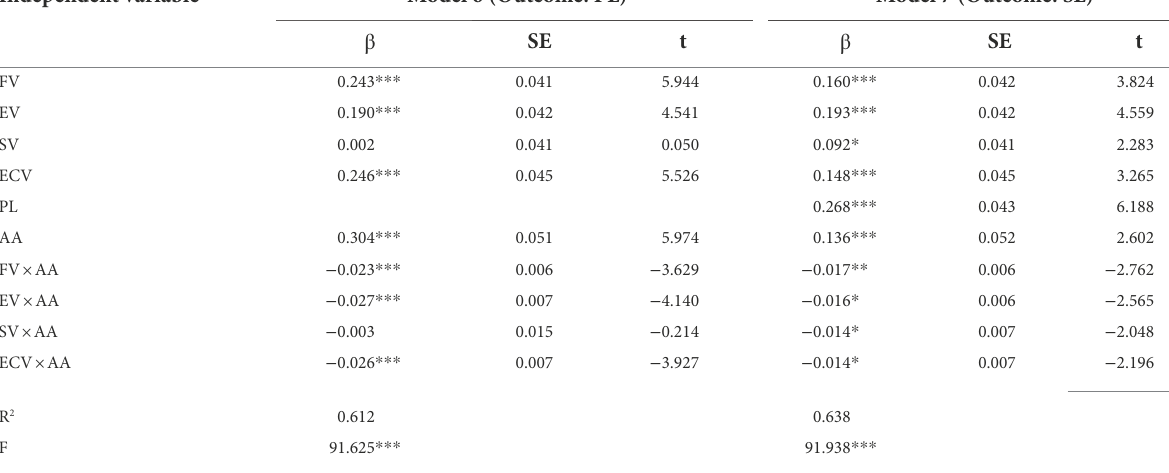
TABLE 10 Moderation effect of alternative attractiveness.